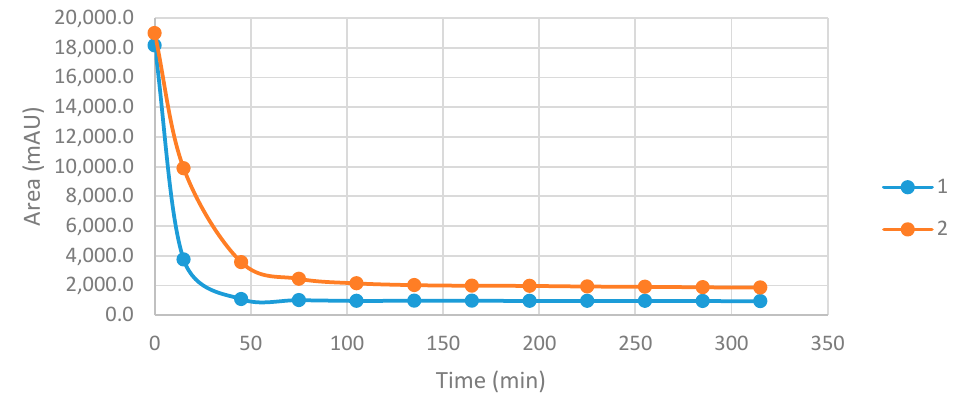
Figure 4. Change in the chromatographic peak area of chalcones 1 and 2 in the chalcone–NAC incubations at pH 8.0/8.5.